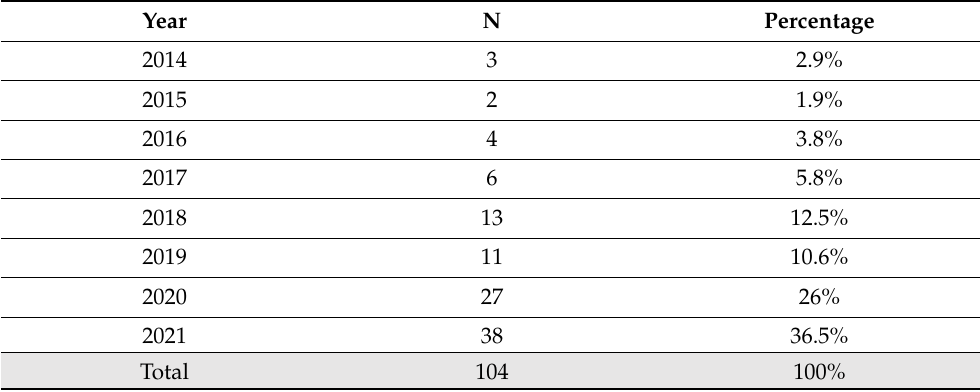
Table 1. Descriptive analysis (distribution of the total number of articles by year).